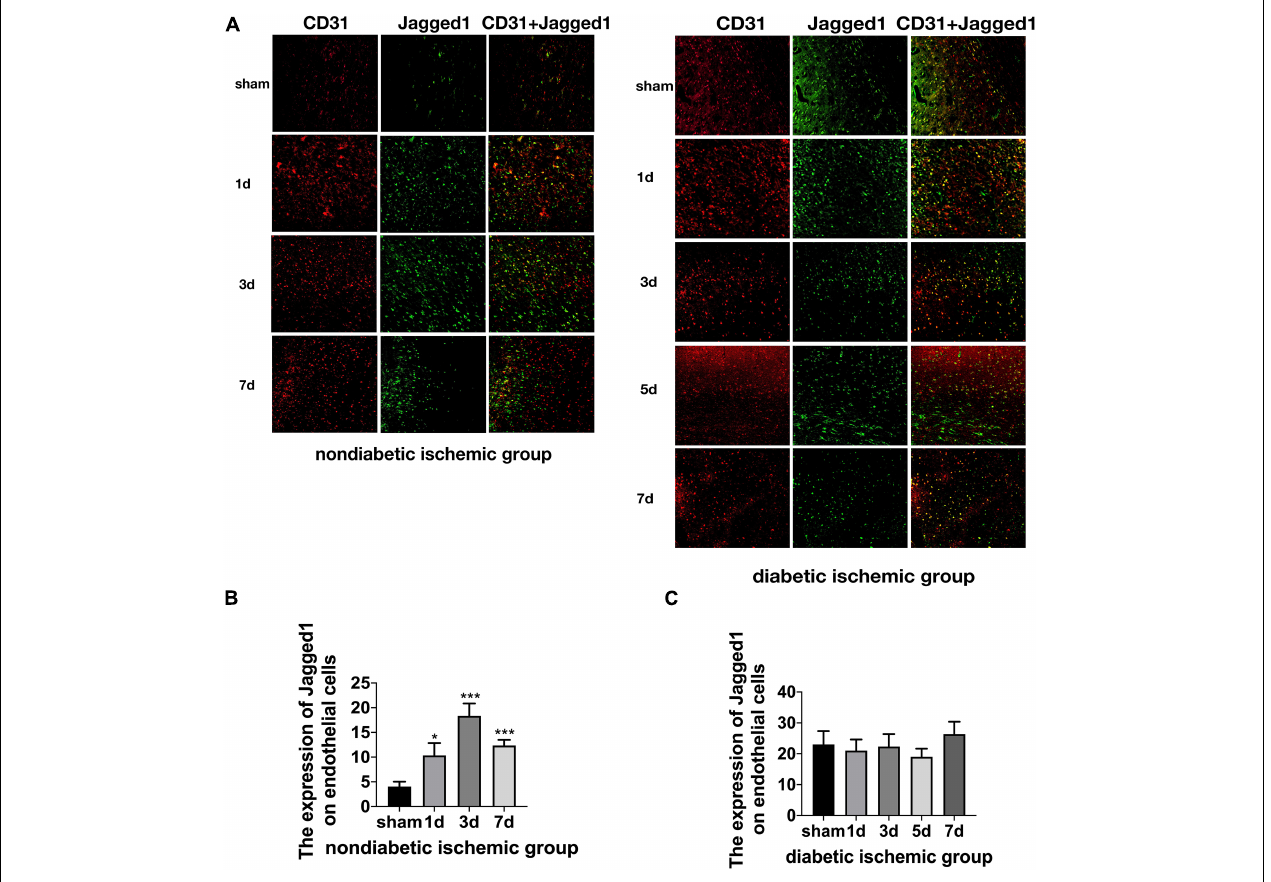
FIGURE 5 | Suppressed Jagged1-Notch1 signaling after acute ischemic stroke in T2DM. (A–C) The expression of Jagged1 and CD31 was assessed by immunofluorescence staining in ischemic penumbra (Magnification × 200. Scale bar = 100 µ m) and the positive cells of Jagged1 and CD31 were calculated ( n = 3 per group). * p < 0.05 vs. sham group, *** p < 0.001 vs. sham